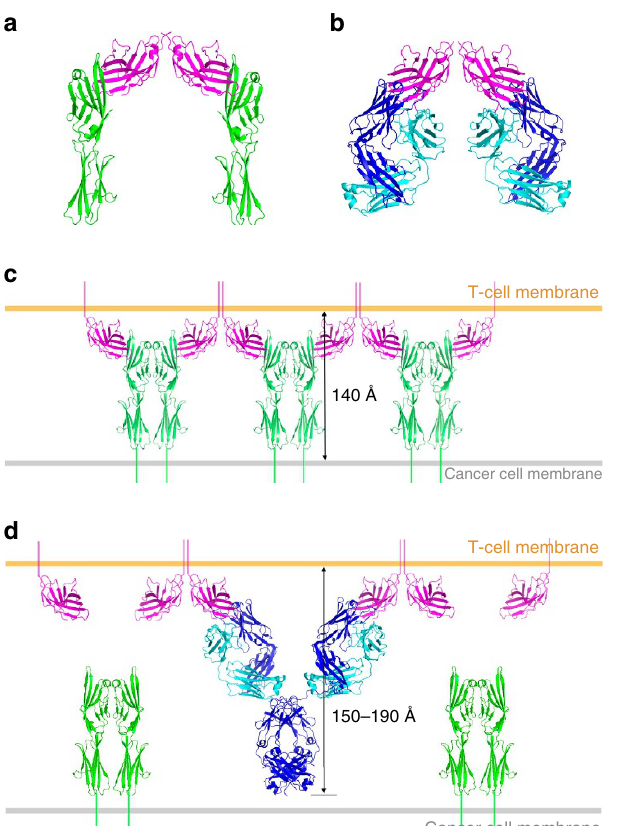
Figure 8 | Hypothetical model for prevention of an alternating arrangement of bivalent dimers of CTLA-4 and B7-1/2 by tremelimumab binding. ( a ) Structure of CTLA-4 dimer (purple) binding to two B7-1 molecules (green) (PDB code 1i8l). ( b ) Structure of CTLA-4 dimer (purple) binding to two tremelimumab Fab fragments (heavy chain: blue, light chain: cyan) in the crystal. ( c ) Suggested model for an alternating periodic arrangement of bivalent dimers of CTLA-4 and B7-1 at the interface between a T-cell and cancer cell, imposing an intercellular distance of B 140Å 23,24 . ( d ) Suggested model for the bivalent interaction of tremelimumab with CTLA-4. Tremelimumab binds two CTLA-4 molecules in the vicinity of the two binding site of IgG, spanning 150–190Å in the perpendicular direction from the T-cell membrane. re-suspended in lysis buffer (20mM Tris, pH 8.0, 200mM NaCl) and lysed by sonication on ice. Inclusion bodies were recovered by centrifugation (25,000 g for 0.5h at 4 (cid:2) C) and solubilized in 8M urea, 20mM Tris, pH 8.0, 200mM NaCl by stirring overnight. After removing undissolved residue by centrifugation (25,000 g for 0.5h at 4 (cid:2) C), solubilized fraction was applied to HisTrap HP column (GE Healthcare Life Sciences) and washed with five column volumes of wash buffer (8M urea, 20mM Tris, pH 8.0, 200mM NaCl, 50mM imidazole). The protein was then eluted with elution buffer (8M urea, 20mM Tris, pH 8.0, 200mM NaCl, 400mM imidazole). The eluted protein was refolded by dialysis three times against 20mM Tris, pH 8.0, 200mM NaCl and purified further by gel filtration